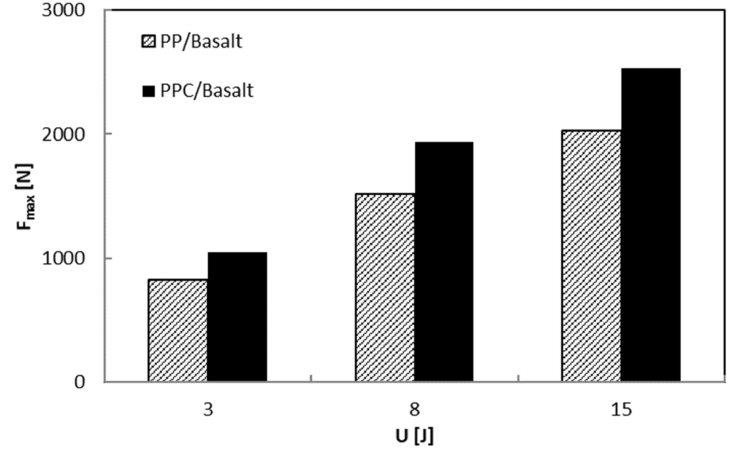
Figure 10. Maximum load, F max , versus impact energy,